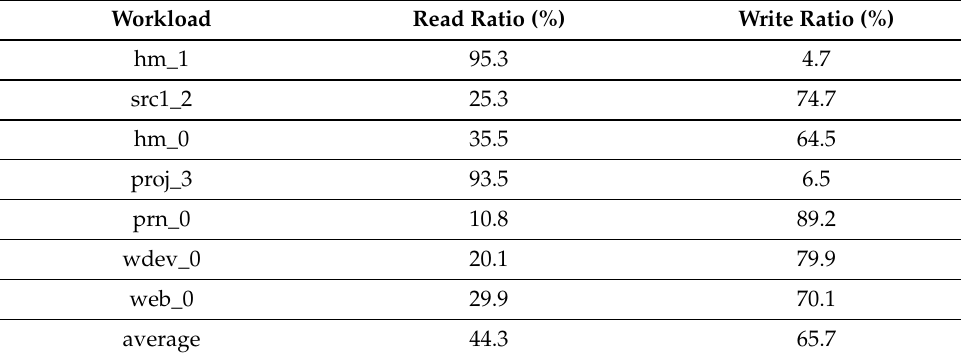
Table 3. Request ratio of seven workloads selected from